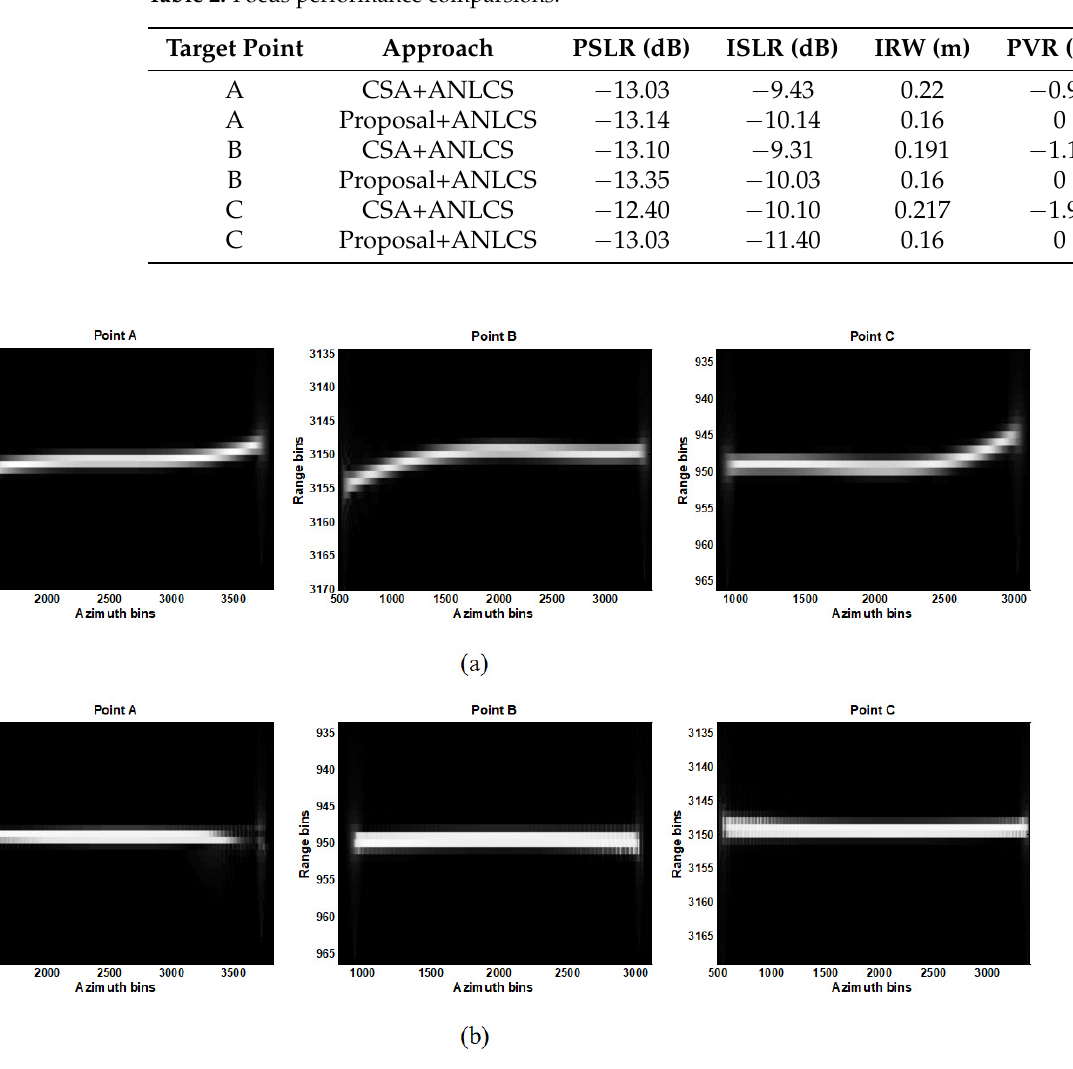
Figure 5. RCMC comparisons of chirp scaling algorithm (CSA) and proposal. ( a ) RCMC of points A, B, and C using CSA; ( b ) RCMC of A, B, and C using the proposed